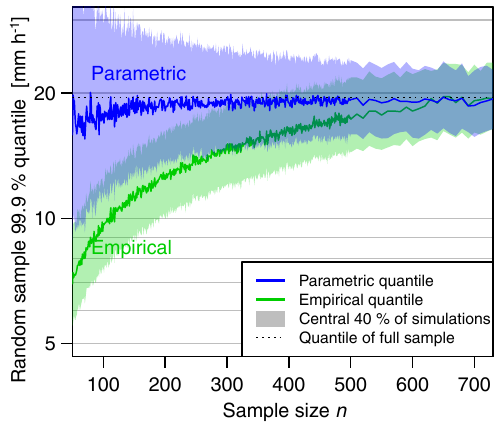
Figure 2. Median of the empirical and parametric 99.9% quantile estimates depending on the size of samples drawn from all the pre- cipitation intensity values along with their uncertainty bands. The horizontal dashed line marks the empirical quantile of the complete dataset ( n = 1 . 16 million). For n > 500, we used a step size of 10 (instead of 1) for the sample size, so the curve appears smoother